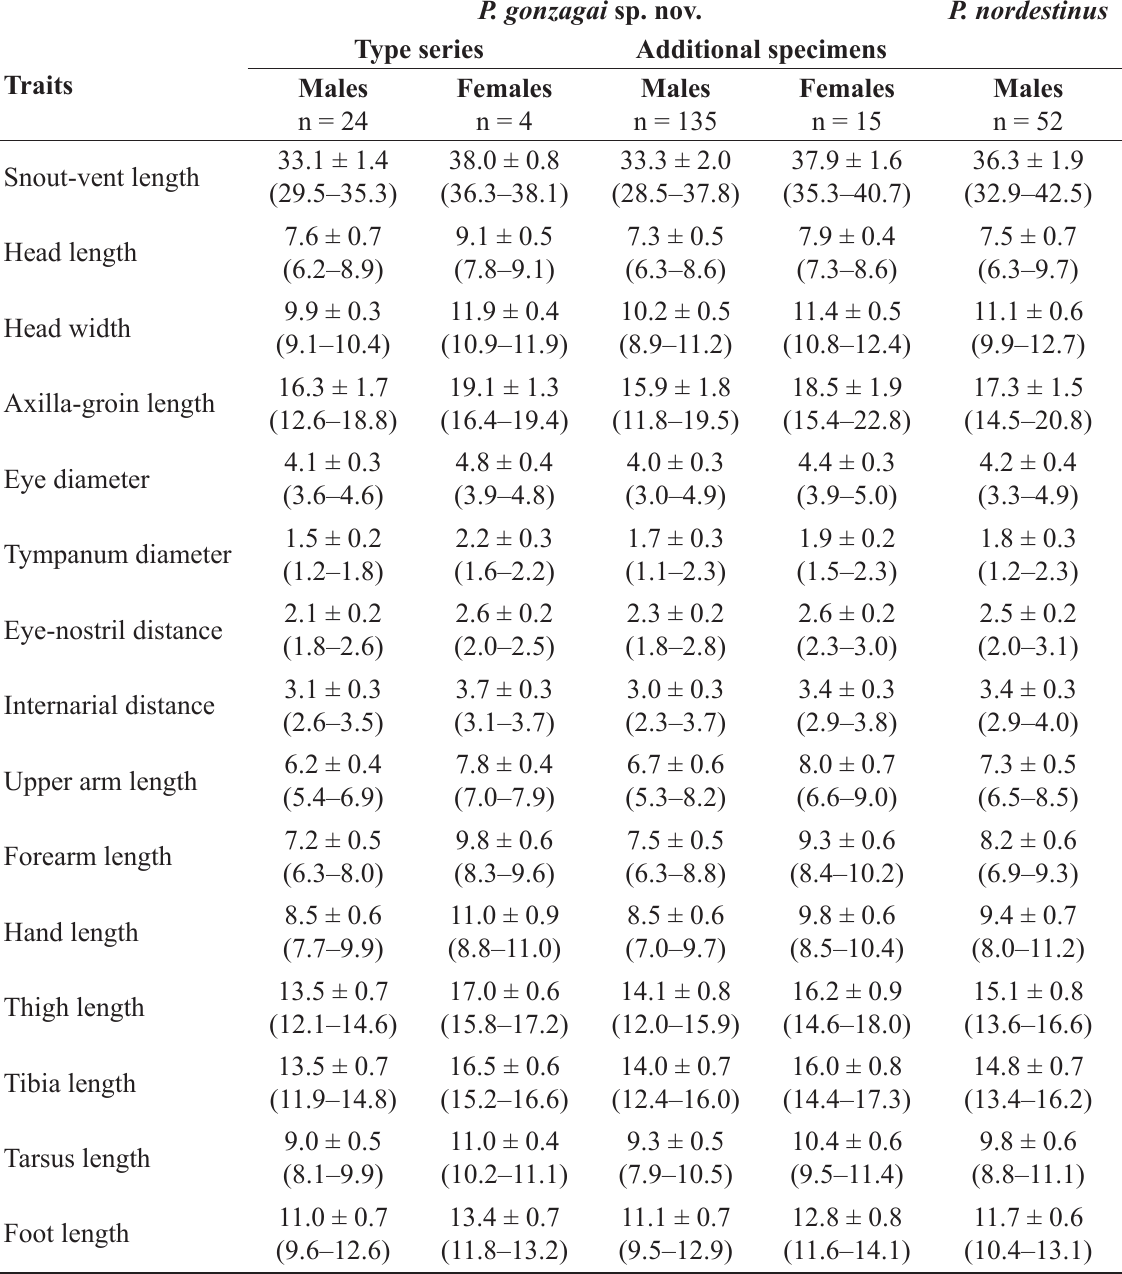
Table 1. Morphometry of adult specimens of Pithecopus gonzagai sp. nov. (type series, 24 males including the holotype, and 150 individuals from 16 localities across four northeastern Brazilian states), and P. nordestinus (Caramaschi, 2006) (52 males including the holotype and 20 paratopotypes). Values presented in millimeters as mean ± standard deviation (range); n = number of specimens